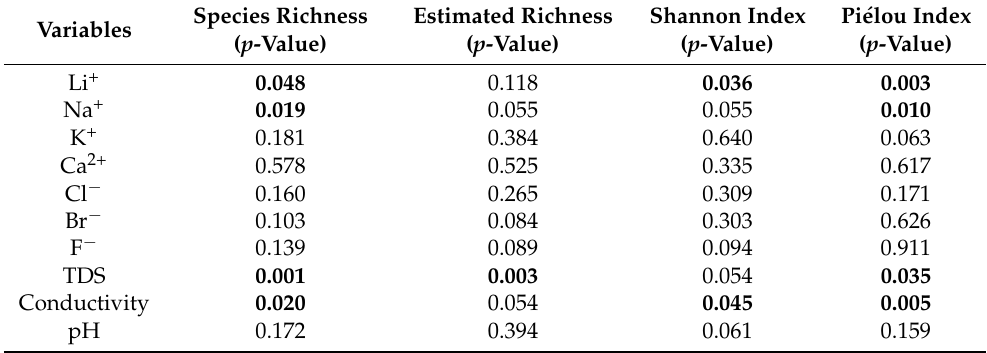
Table 5. Results of the Kruskal–Wallis tests performed on the physical and chemical variables using the classes performed on the lithium, sodium, potassium, calcium, chloride, bromine, fluoride, TDS, conductivity, and pH. p -values in bold are statistically